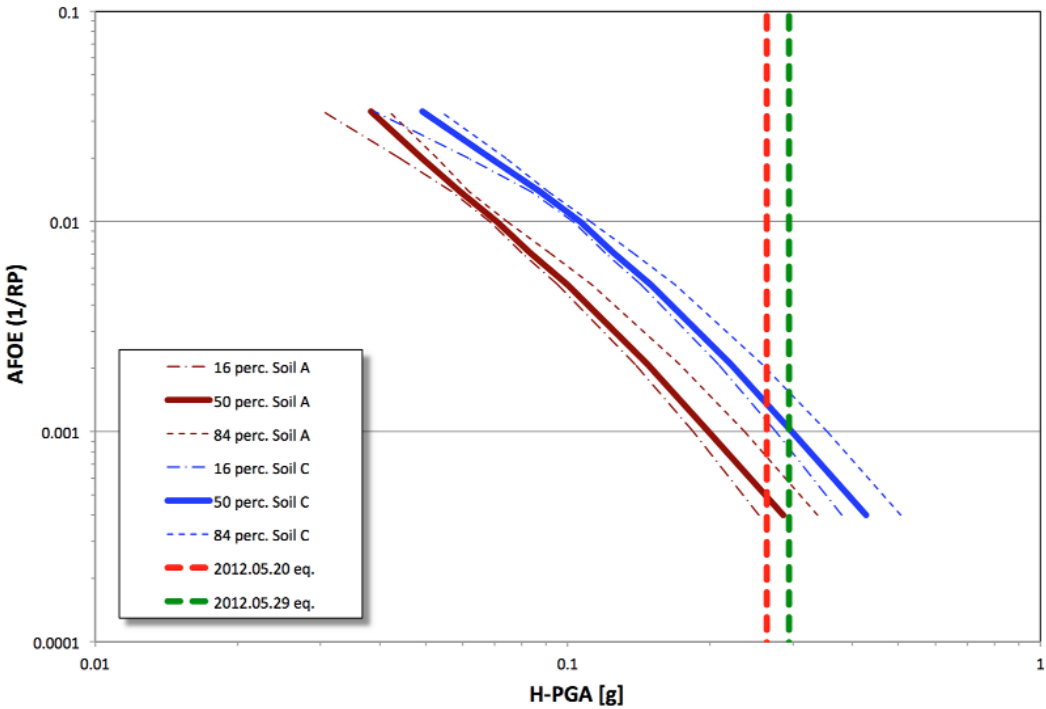
Figure 6. Comparison between the hazard curves for soil types A and C, computed at the node of the computational grid closest to Mirandola and the maximum horizontal PGAs recorded at the MRN station for the May 20 and 29, 2012, earthquakes. The 16th and 84th percentile curves represent the epis- temic uncertainty of the probabilistic seismic hazard estimate.